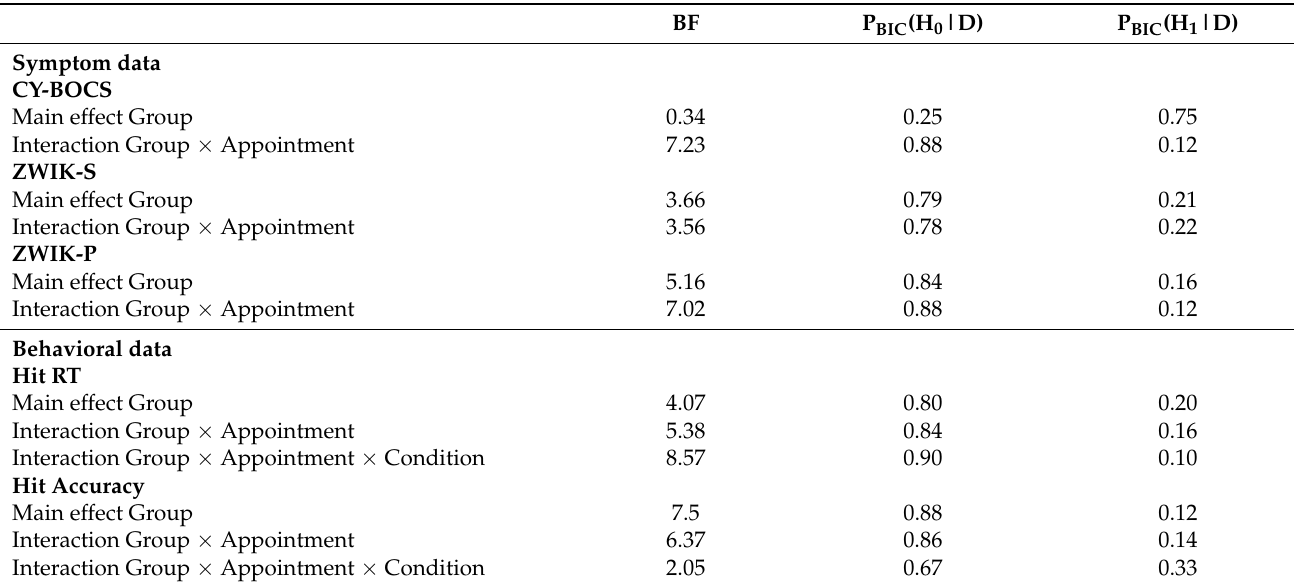
Table 2. Bayesian analyses for each e ff ect of the factor “Group”.